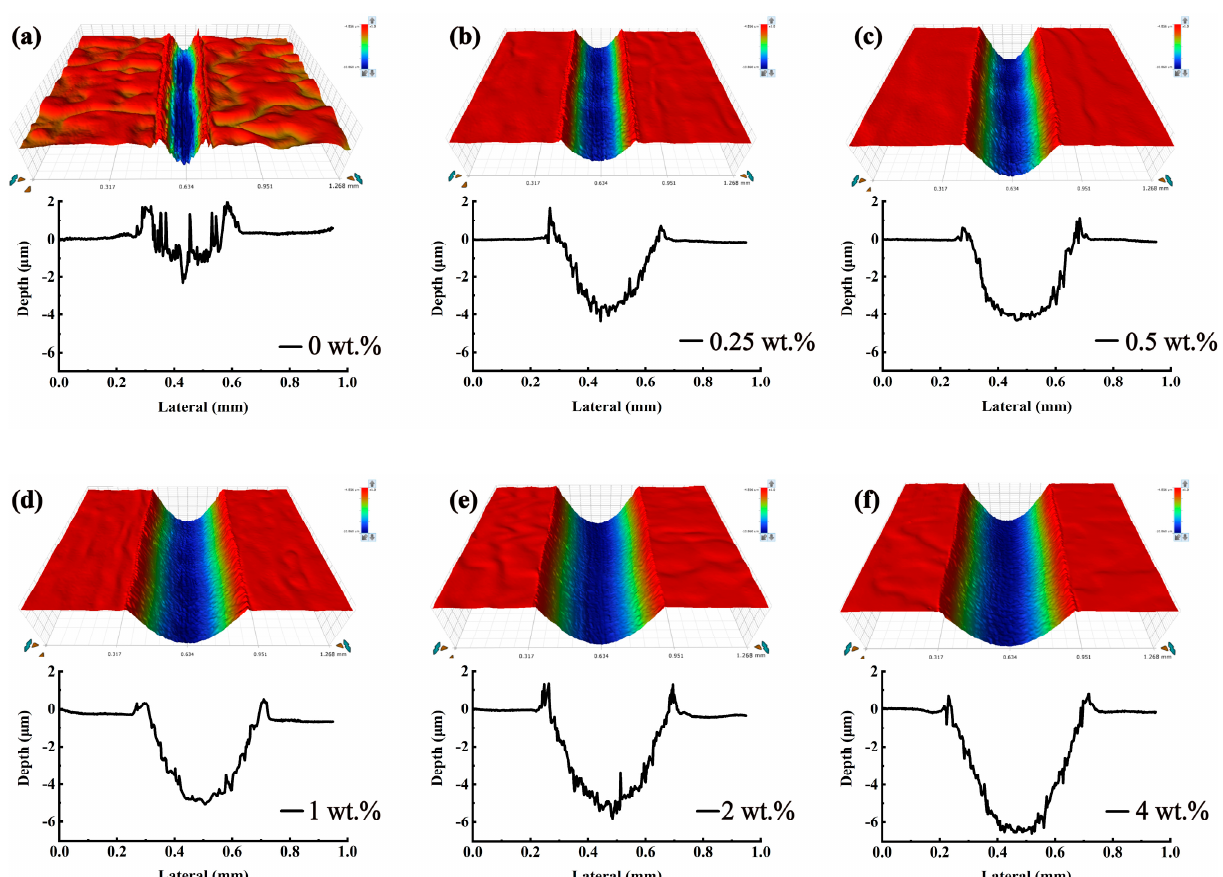
Figure 6. The surface curves and WLI morphologies on the worn disks lubricated using the JD2000 water aqueous solutions with different concentrations: ( a ) 0 wt.%, ( b ) 0.25 wt.%, ( c ) 0.5 wt.%, ( d ) 1 wt.%, ( e ) 2 wt.% and ( f ) 4 wt.% .